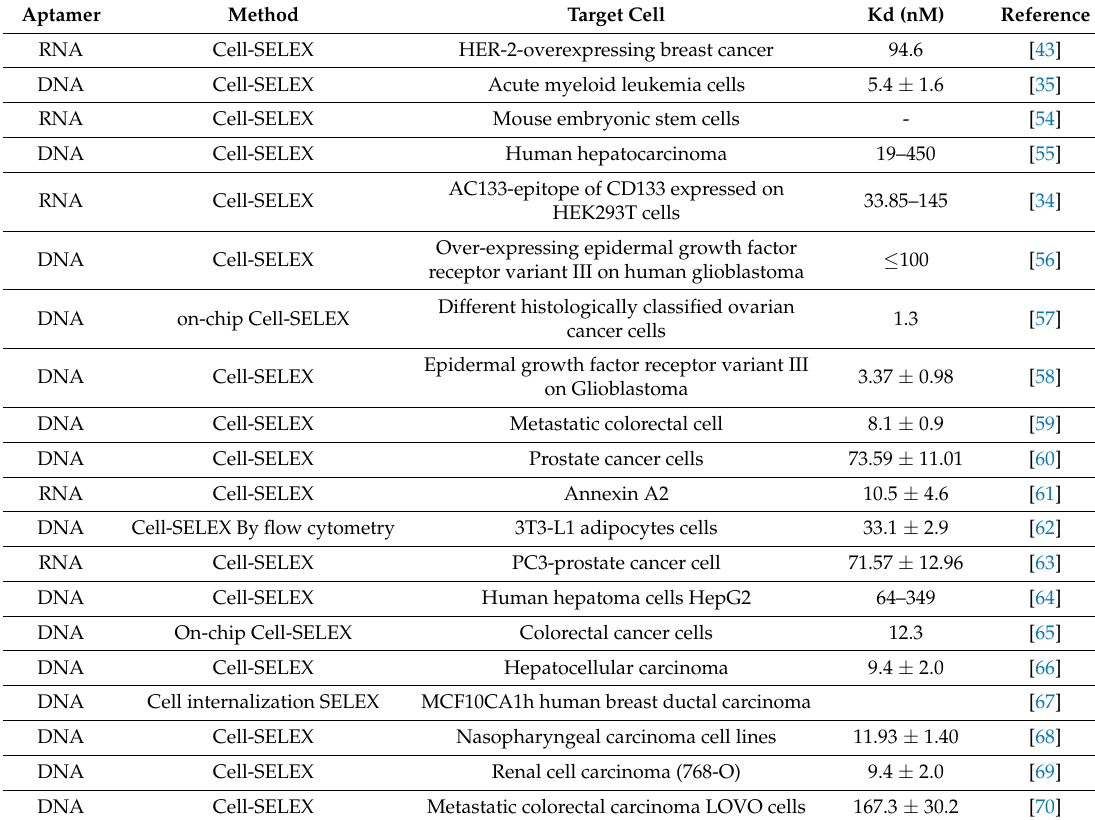
Table 1. Summary of different Cell-SELEX experiments performed in the last few